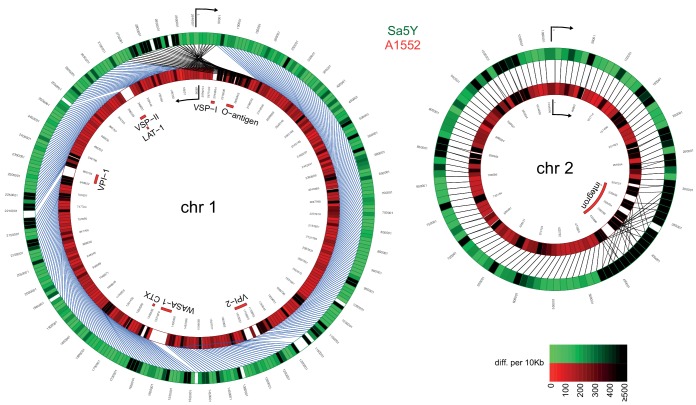
Comparative genomics of pandemic strain A1552 and the environmental isolate Sa5Y.The genomic sequences of chr 1 and 2 of Sa5Y (green) were segmented in 10-kbp-long fragments and aligned against the respective chromosome of the reference A1552 (red). To simplify visualization, chr 1 of strain A1552 was inverted and plotted counter-clockwise relative to Sa5Y (due to the large inversion in this strain; see Materials and methods section), as indicated by the arrow. To represent the differences between the two genomes, a color intensity scale was used that corresponded to the number of differences (SNP or indel), from 0 to ≥500 as measured per 10 kbp fragment (same values are indicated for both colors). White regions show no homology. Important genomic features of pandemic V. cholerae are highlighted inside the rings.